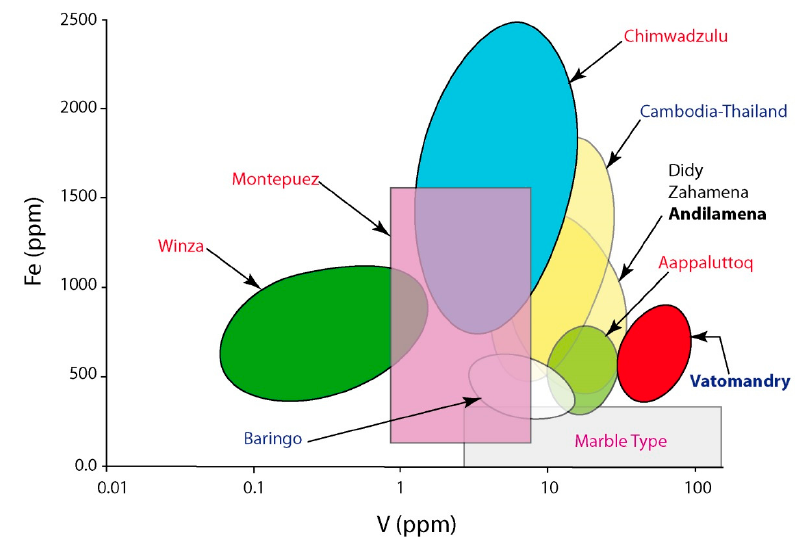
Figure 60. V versus Fe (in ppm) for the main ruby deposits of Madagascar (Vatomandry, Andilamena, Didy, Zahamena) and other deposits worldwide (Kenya, Baringo; Greenland, Aappaluttoq; Tanzania, Winza; Mozambique, Montepuez; Malawi, Chimwadzulu; Cambodia and Thailand; and finally deposits of marble type from Central and Southeastern Asia). Chemical data from [200,267] and Pardieu unpublished data. The chemical domain of ruby from Vatomandry is clearly separated from all the other ones and this parameter permits to precise its geographic origin. The name of ruby deposits related respectively, to M-UMR is written in red (Types IIA 1 , IIB 1 ), to marble deposits in violet (Type IIB 2 ), to alkali- basalt in blue (Type IIIA), and to metamorphic environment in black (Type IIIB).